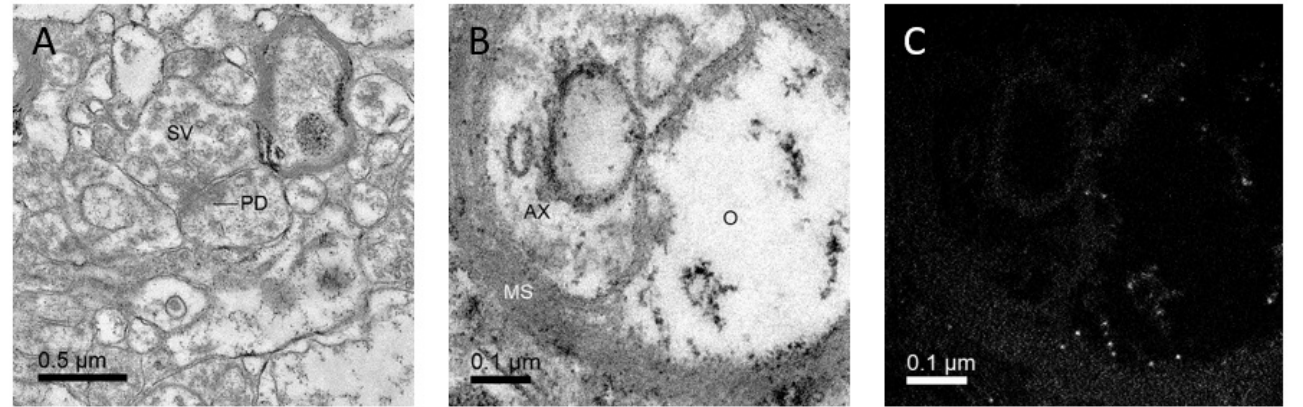
Figure 2. Conventional electron microscopy allows visualizing synapses and analytical electron microscopy allows visualizing iron-loaded ferritin. ( A ): Conventional electron micrograph of a synapse in a human cortex sample. Synaptic vesicles (SV), postsynaptic density (PD). ( B , C ): Conventional electron micrograph ( B ), and corresponding iron L-map ( C ) from a sample of the human globus pallidus. The bright spots in ( C ) correspond to ferritin particles within an oligodendrocyte (O). AX—axon; MS—myelin sheath.